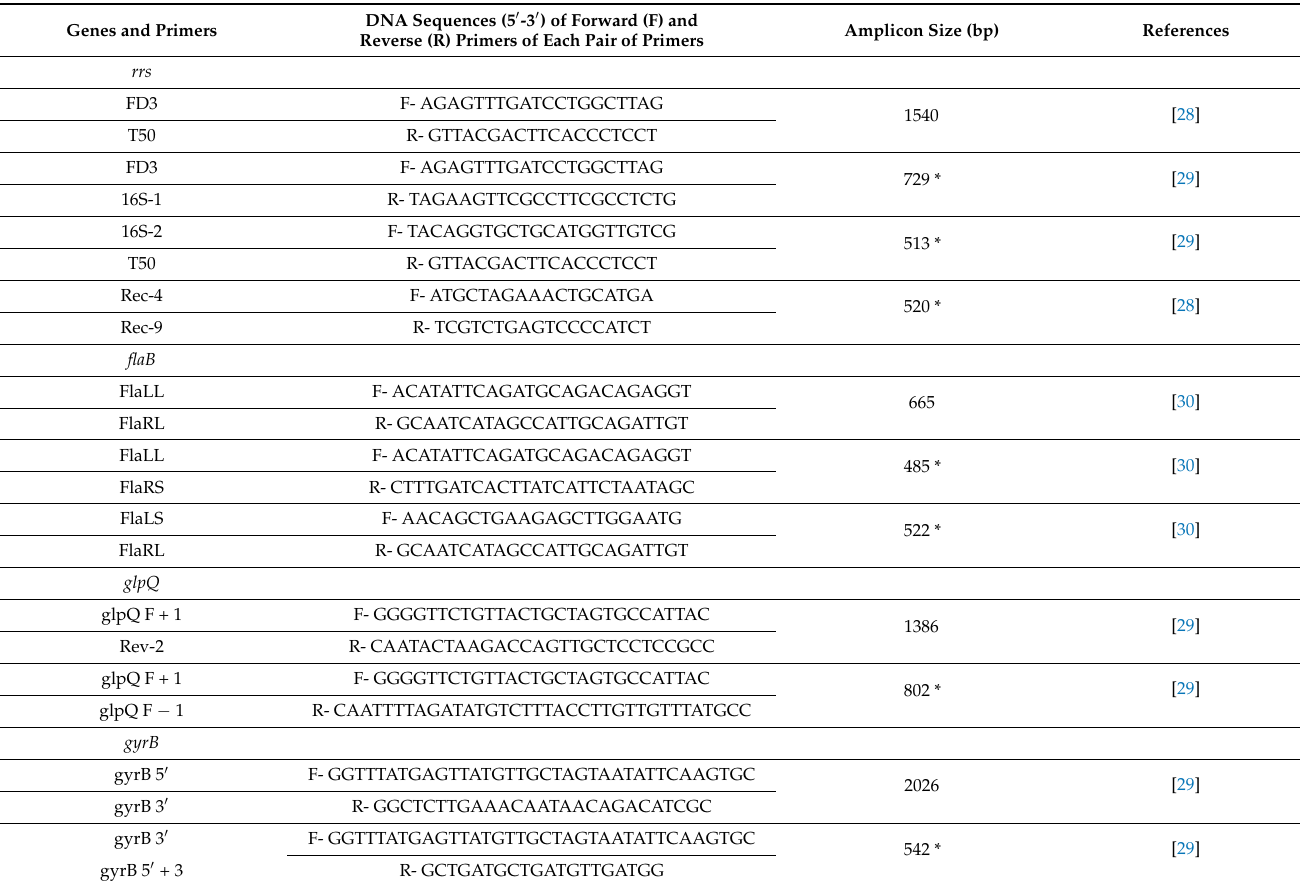
Table 1. List of the primer pairs used in the study for amplification of four Borrelia genes by conven- tional PCR